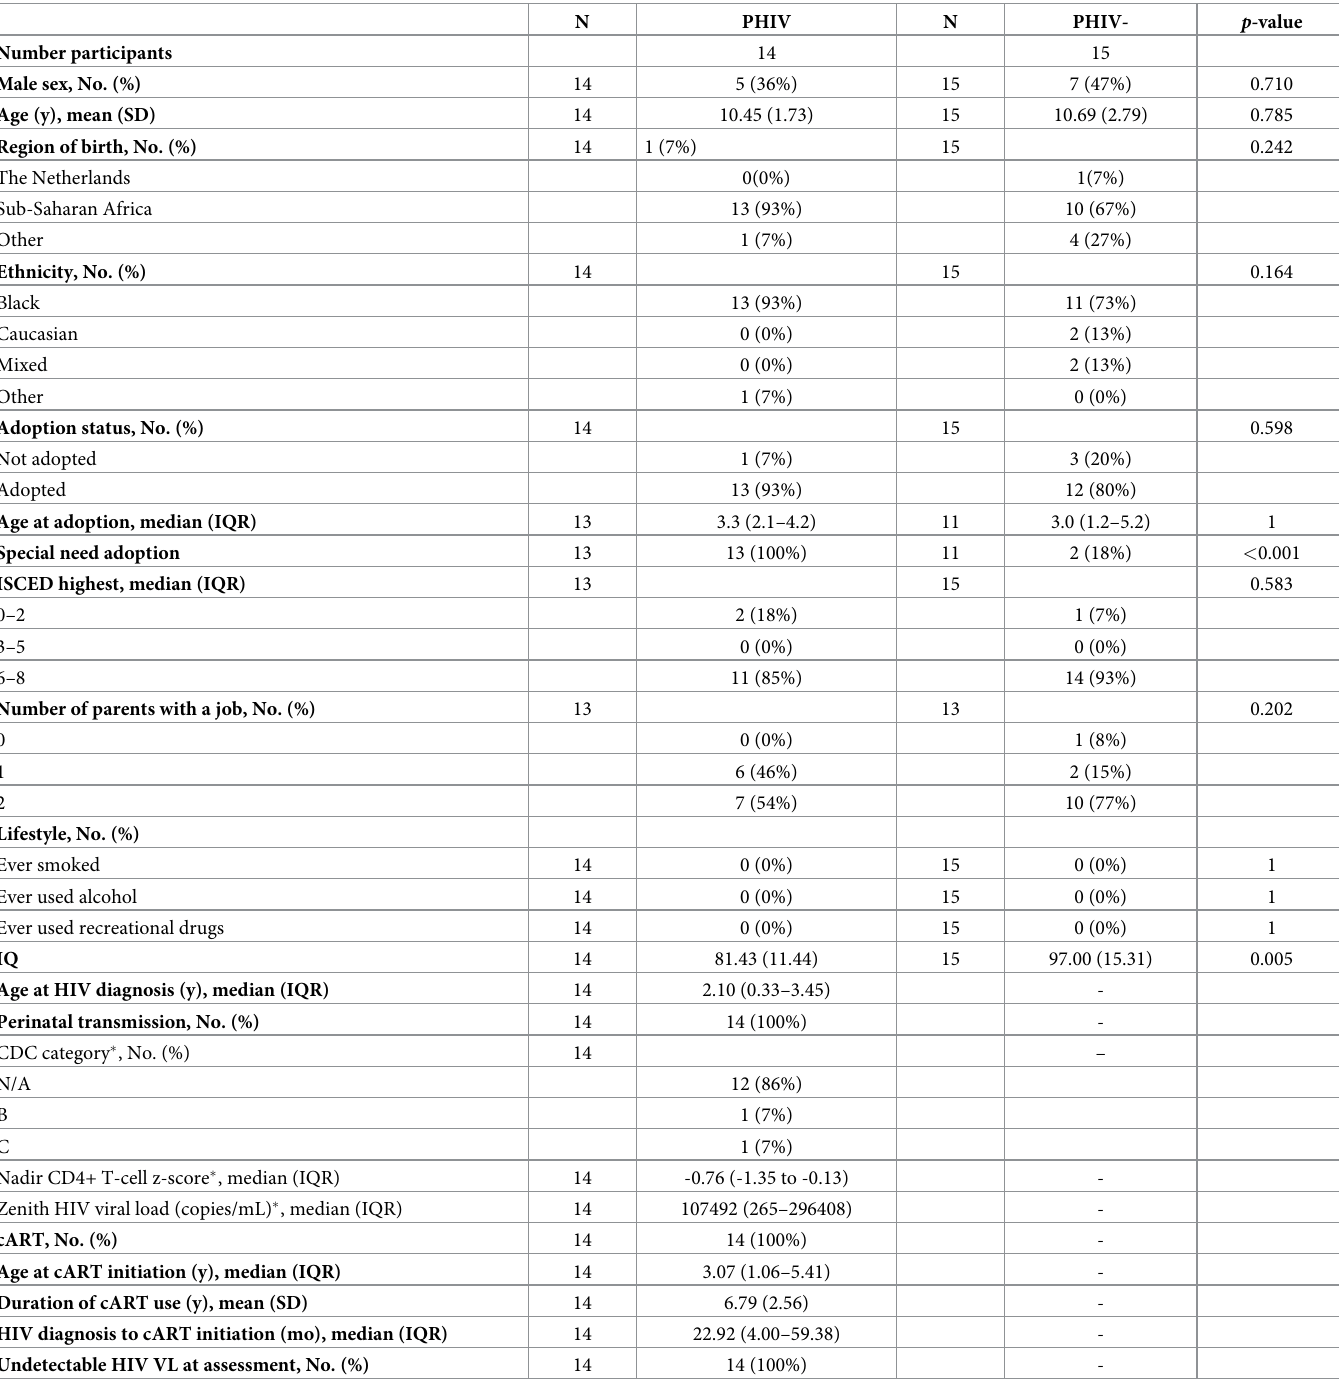
Table 1. Demographics and disease characteristics of Perinatally Human Immunodeficiency Virus (PHIV)-infected (PHIV) and PHIV uninfected (PHIV-) follow- up participants in the NOVICE cohort. N PHIV N PHIV- p